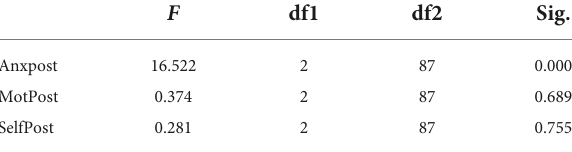
TABLE 3 Results of Levene’s test of equality of error